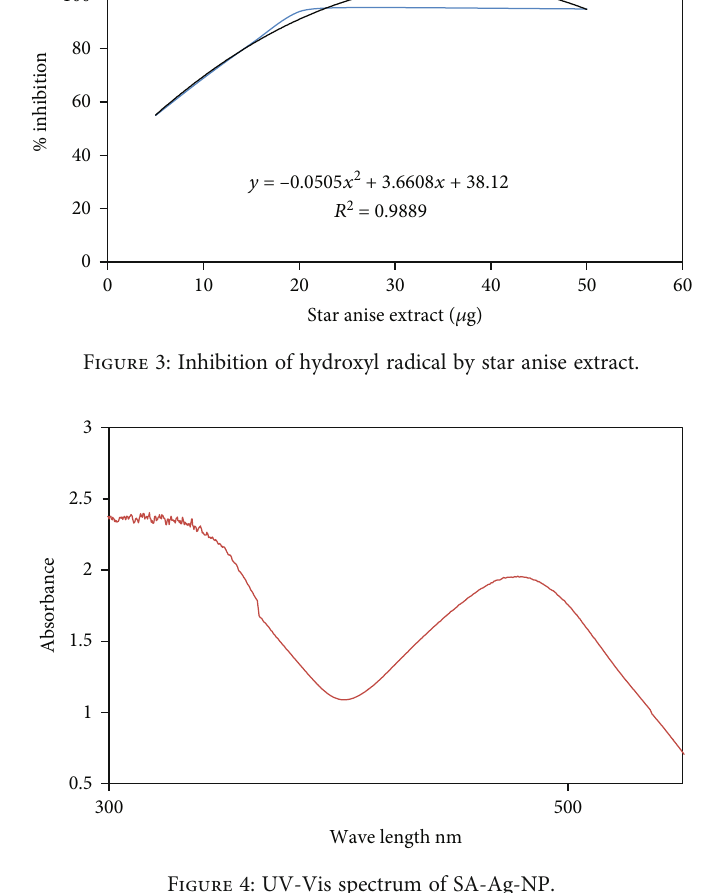
Figure 4: UV-Vis spectrum of SA-Ag-NP.